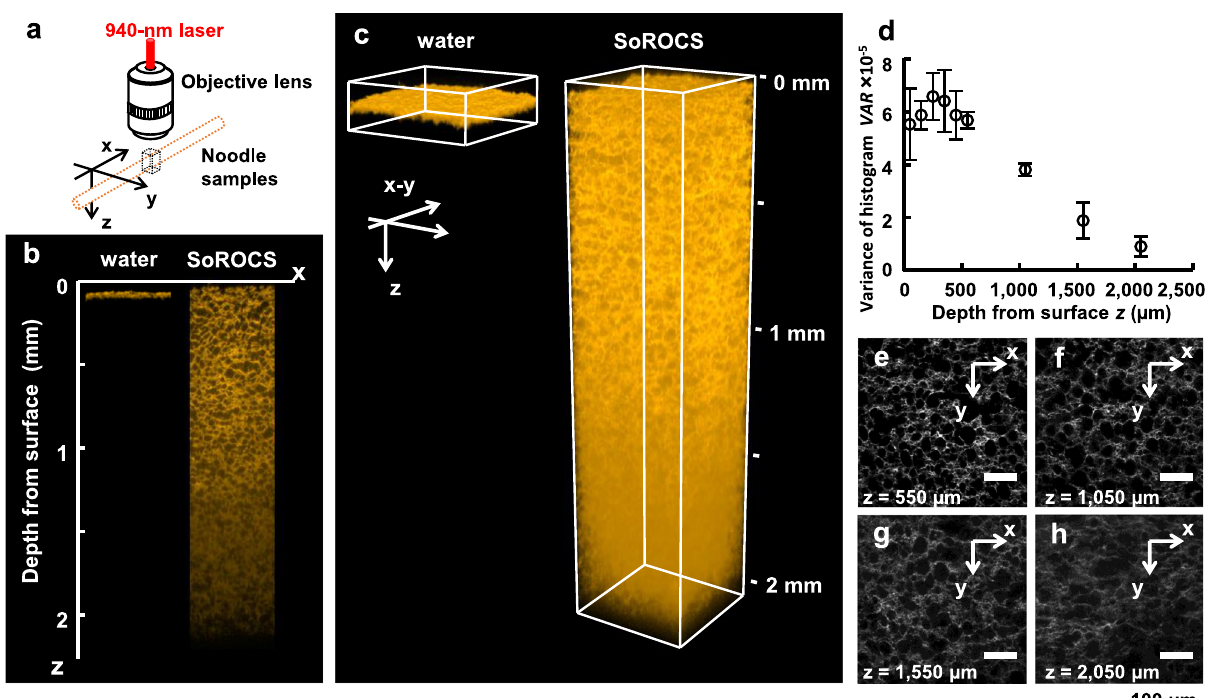
Fig. 4 3D reconstruction of gluten in whole noodle. a Experimental setup for 2PEM imaging. b Comparison of deep imaging of noodles treated with water (left) and SoROCS (right). c 3D reconstruction of gluten for noodle treated with water (left) and SoROCS (right). Note that when rendering with FluoRender, gamma change (3.2) and alpha blending (500) were applied and a threshold was set to 146 and 90 for water and SoROCS, respectively ( b , c ). d The fl uorescent image quality of gluten depending on the depth from the surface of the noodles. Data are presented as mean values± SD ( N = 3 independently prepared noodle samples). One of the section images obtained from these three different samples is shown in ( e – h ), respectively. Note that the 2D imaging conditions with 2PEM were adjusted to be optimal for each depth ( d – h ). Optical sections at several depths: z = 550 µ m ( e ), z = 1050 µ m ( f ), z = 1550 µ m ( g ) and z = 2050 µ m ( h ). Scale bars indicate 100 µ m ( e – h ). Source data underlying ( d ) are provided as a Source Data fi